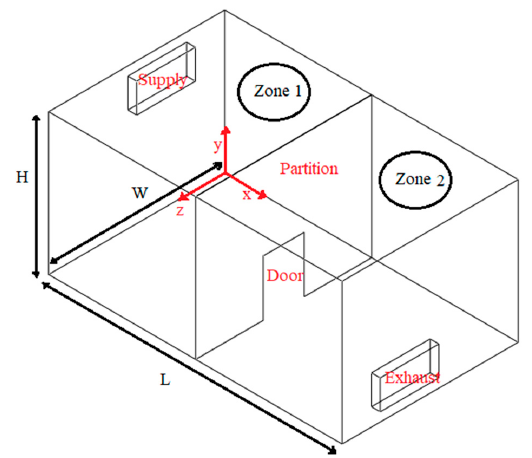
Figure 7. 3D view of the zones.